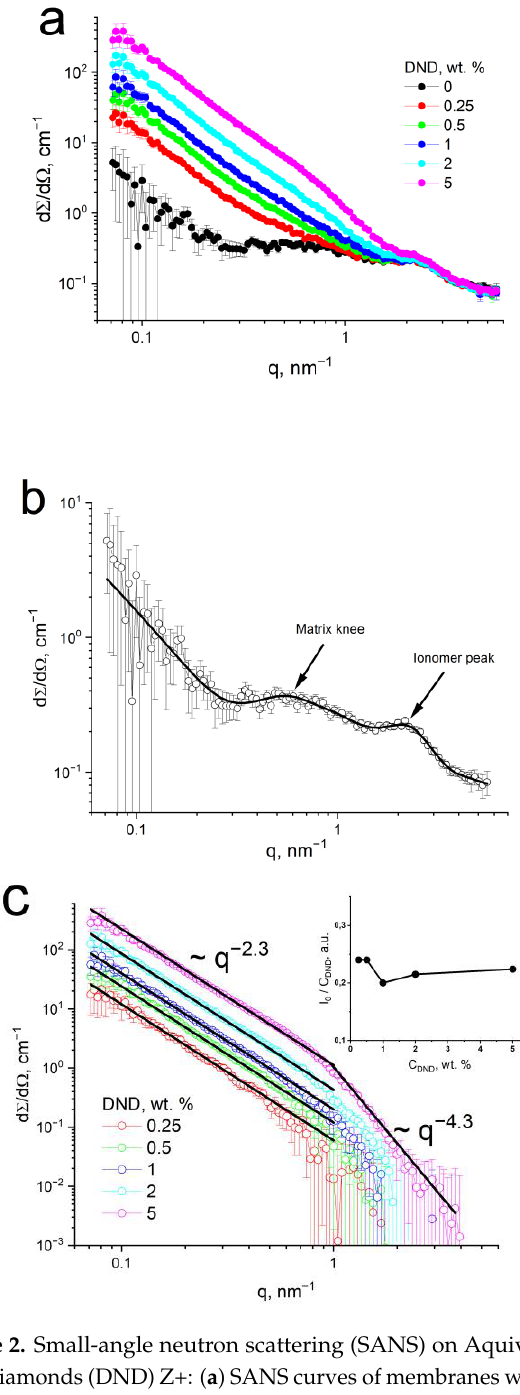
Figure 2. Small-angle neutron scattering (SANS) on Aquivion ® -type membranes with detonation nanodiamonds (DND) Z+: ( a ) SANS curves of membranes with a DND content of 0–5 wt.%; ( b ) SANS on a sample without DNDs: the points are experimental data and the solid curve is a fitting result using Equation (2); and ( c ) differential SANS curves of membranes without DNDs subtracted from compositional membranes with DNDs, demonstrating the DND distribution in membranes (the points are experimental data, the solid lines are the power-law approximation, and the inset shows the intensity of the power-law approximation normalized by the DND content in membranes vs. the DND content). Table 2. Fitting parameters for Small-angle neutron scattering (SANS) on an Aquivion ® -type mem- brane without detonation nanodiamonds (DND), using Equation (2).